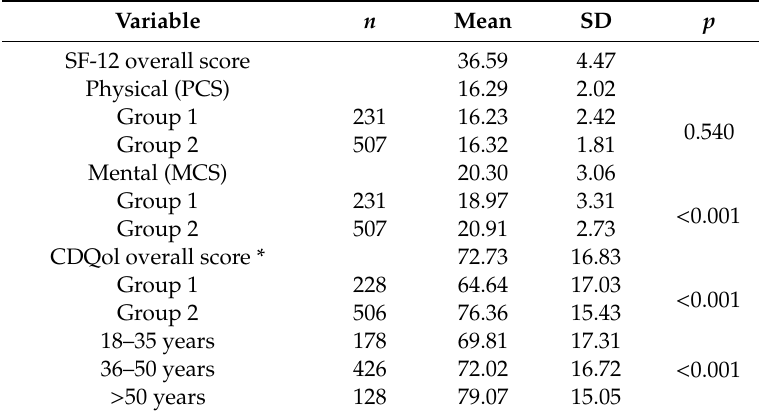
Table 4. Health-related quality of life (HRQoL), according to SF-12 and CDQol results, by adherence and age group ( n =